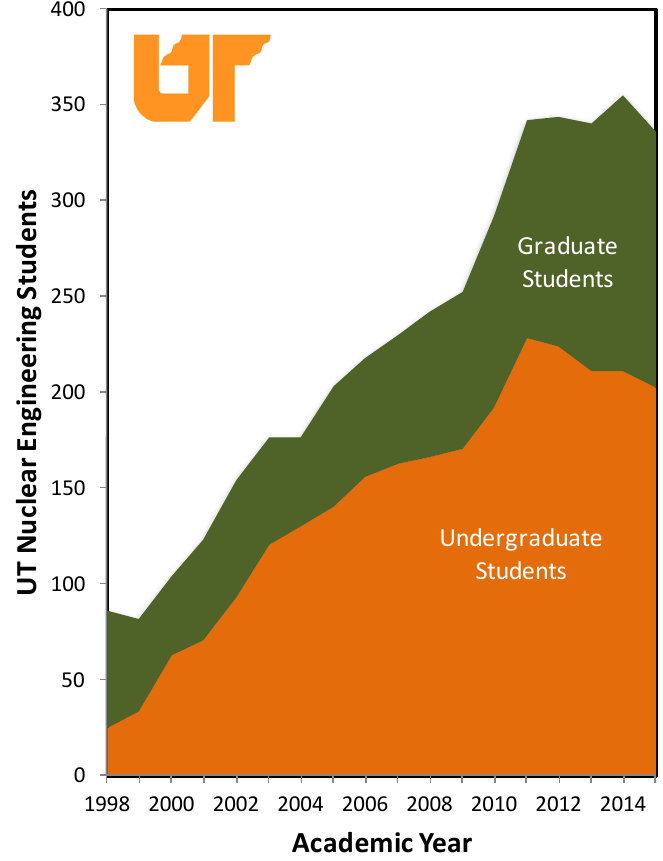
Figure 2: Aggregate enrollment in UT Nuclear Engineering program from 1998 to 2015. Numbers reflect 14-day enrollments for the fall semester of each academic year.